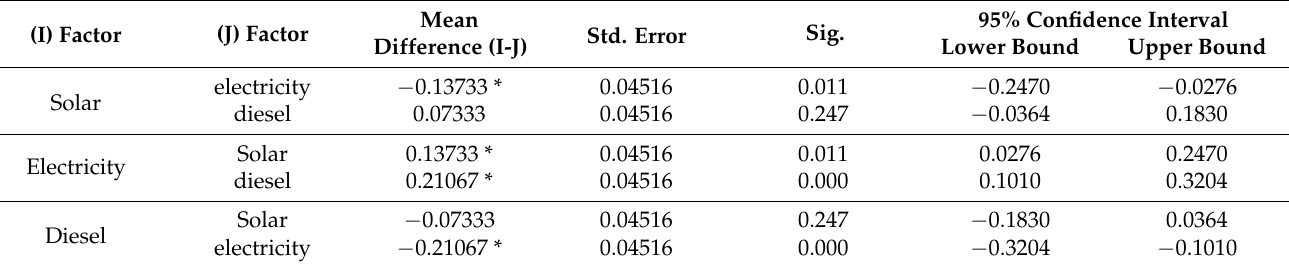
Table 3. Post hoc Tukey test for B-C ratio.